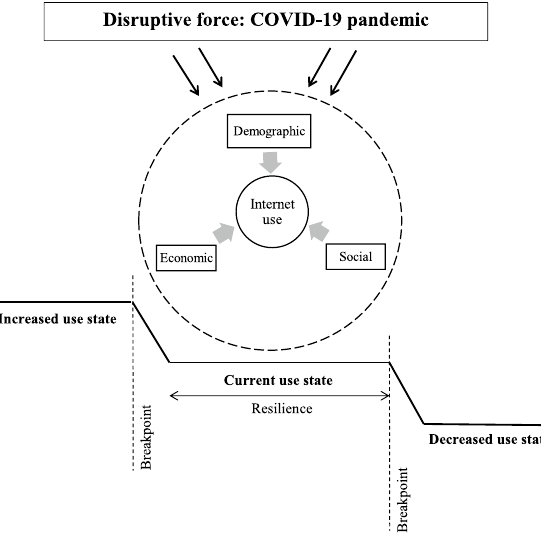
Figure 1. An adaptation of the Dynamics in Technology Use by Seniors (DITUS) framework. The DITUS framework 18 was developed to explain technology use by independent-living seniors over time. The framework posits a core of interrelated factors linked to technology use, as well as disruptive forces that can induce changes to other levels of use. In line with these concepts, the primary research questions in this study are, (1) were there changes in Internet use patterns among older adults after the outbreak of the COVID-19 pandemic, and (2) what were the factors predicting Internet use after the outbreak of the